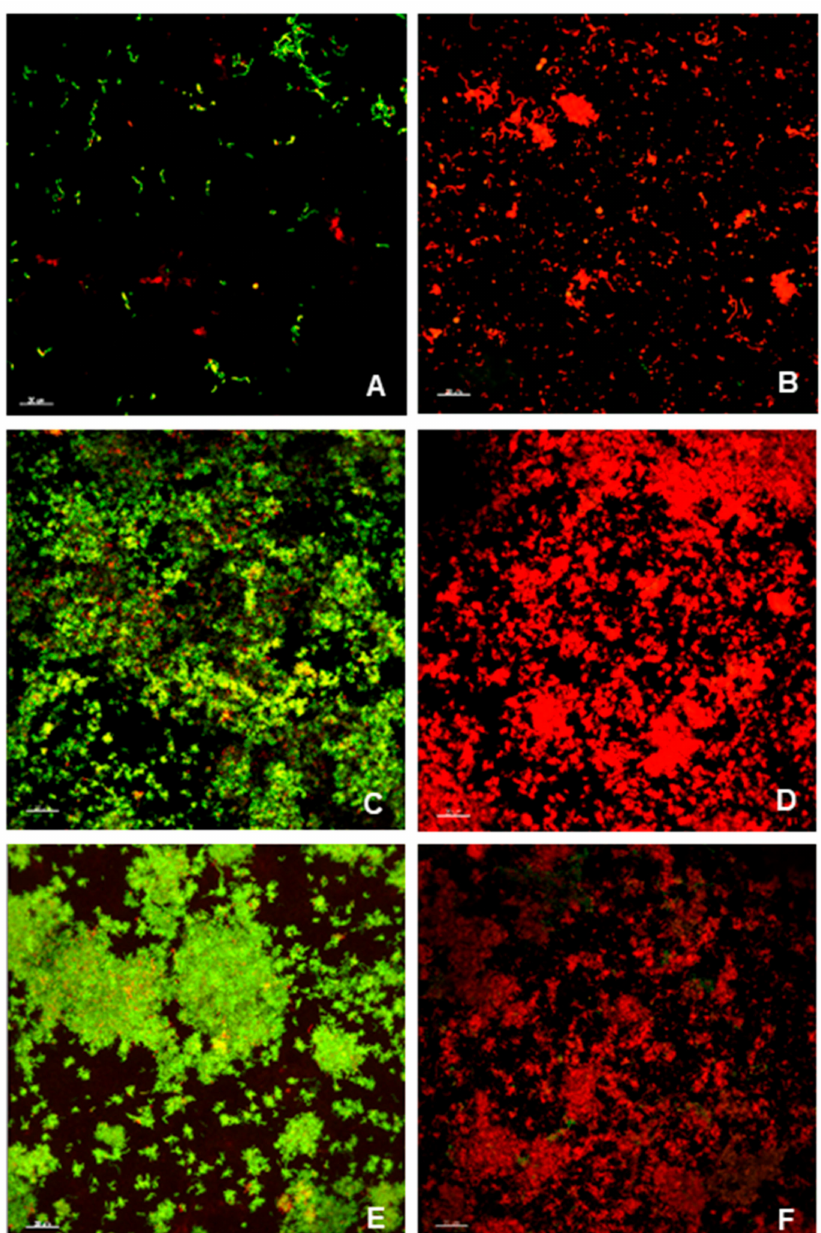
Figure 4. S. mutans and A. naeslundii biofilms—A: non-treated (NaCl) S. mutans biofilms; B: treated (CHX) S. mutans biofilms; C: non-treated (NaCl) A. naeslundii biofilms; D: treated (CHX) A. naeslundii biofilms; E: non-treated (NaCl) S. mutans and A. naeslundii biofilms; F: treated (CHX) S. mutans